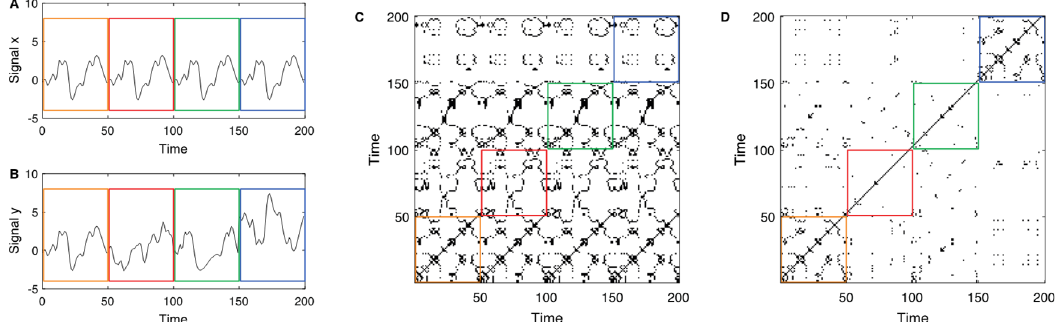
Figure 2. ( A ) Signal 𝑥 with a pattern that repeats four times; ( B ) Signal y with an identical pattern as the signal x in the first epoch, an uncorrelated signal at x in the second epoch, an identical signal as the x but time-deformed in the third epoch, and a transformed signal with respect to x in the fourth epoch. ( C ) CRP between the 𝑥 and 𝑦 signals. A main diagonal is present in the first epoch because both signals are identical, but the diagonal vanishes in the second and the last epoch, because the signals are uncorrelated (second epoch) or the states are different (last epoch); the temporal distortion of the signal is present as a bowed main “diagonal line” in the third epoch. ( D ) JRP between the 𝑥 and 𝑦 signals. The main diagonal is present in the x and y RPs, it is also present in the JRP and, in contrast to the CRP, not used here. For evaluating the synchronization between the systems, the JRP had to be compared with the appearance of the individual RP. The first epoch with the identical signals corresponds to the identical RP for 𝑥 and 𝑦 . In the second and third epochs the individual RP of 𝑥 and 𝑦 are different; therefore, the JRPs are mainly empty. In the fourth epoch, the sub-JRP looks very similar to the individual RP (sub-JRP in the first box). Although they have different state values, the recurrence structure of the x and y signals is equal. The figure is reproduced from Semeraro, T.; Luvisi, A.; Lillo, A.; Aretano, R.; Buccolieri, R.; Marwan, N. Recurrence Analysis of Vegetation Indices for Highlighting the Ecosystem Response to Drought Events: An Application to the Amazon Forest. Remote Sens . 2020 , 12 , 907, https://doi.org/10.3390/rs12060907. (CC BY) © 2021 by the authors